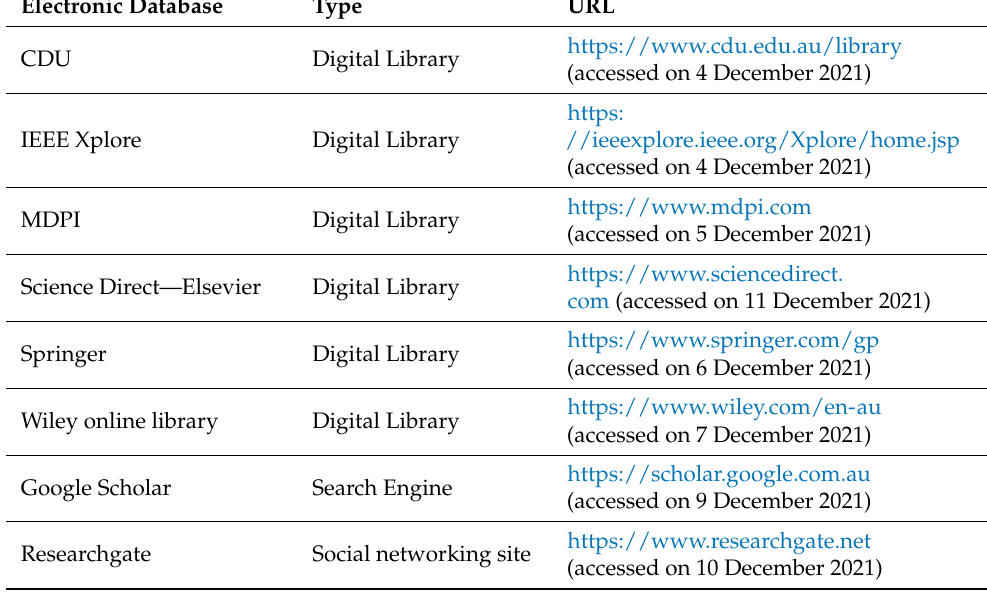
Table 1. Electronic database search.